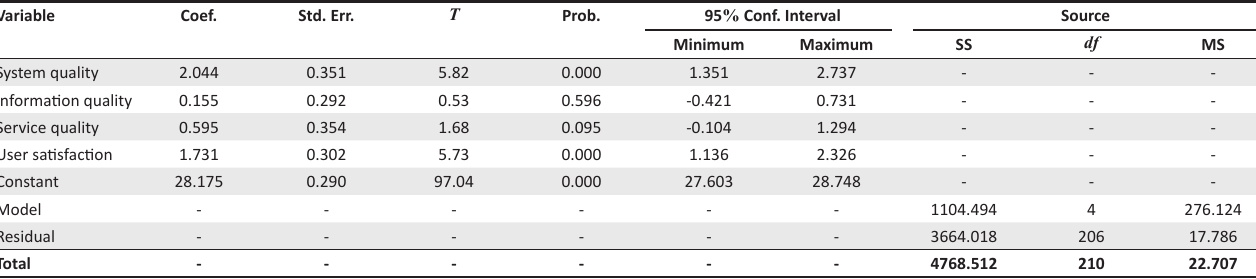
TABLE 7: Regression model for net benefits (with user satisfaction). Variable Coef.